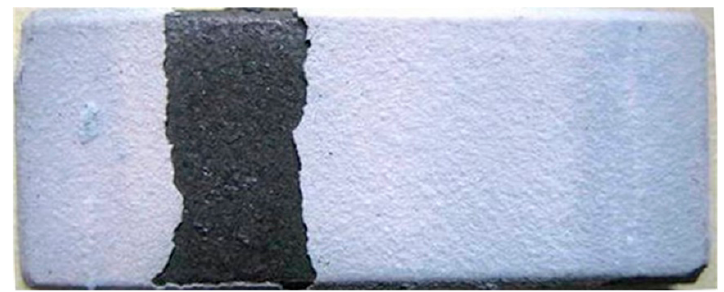
Figure 3. The large-scale spalling of TBCs after oxidizing for 500 h at 1100 ° C [11].